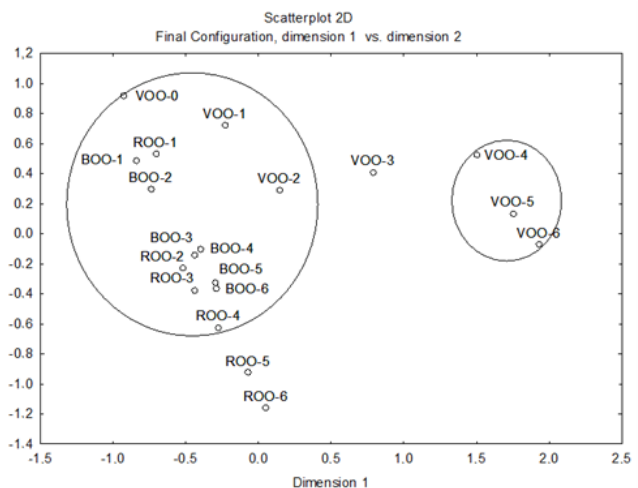
Figure 5. Multi-dimensional scaling (MDS) analysis applied to all the samples. VOO, virgin olive oil; ROO, virgin olive oil flavored with rosemary herbs; BOO, virgin olive oil flavored with basil herbs.